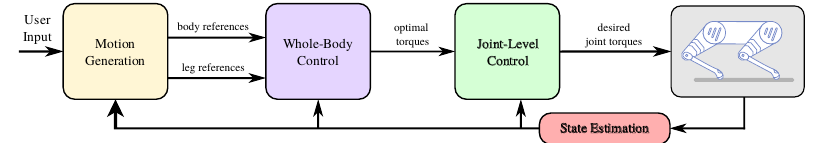
Figure 2. Overview of the locomotion